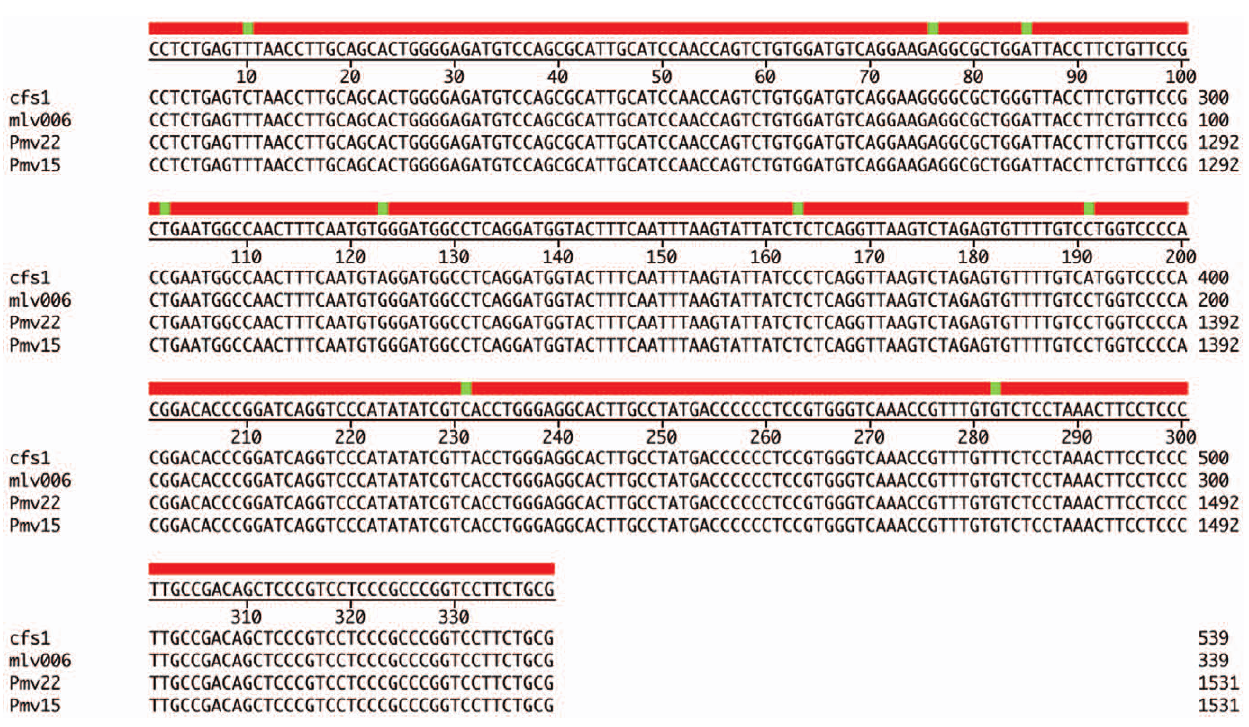
Figure 3. Alignment between cfs1, MLV006, Pmv15 and Pmv22. The nine nucleotide differences between cfs1 and the other viral sequences are highlighted.